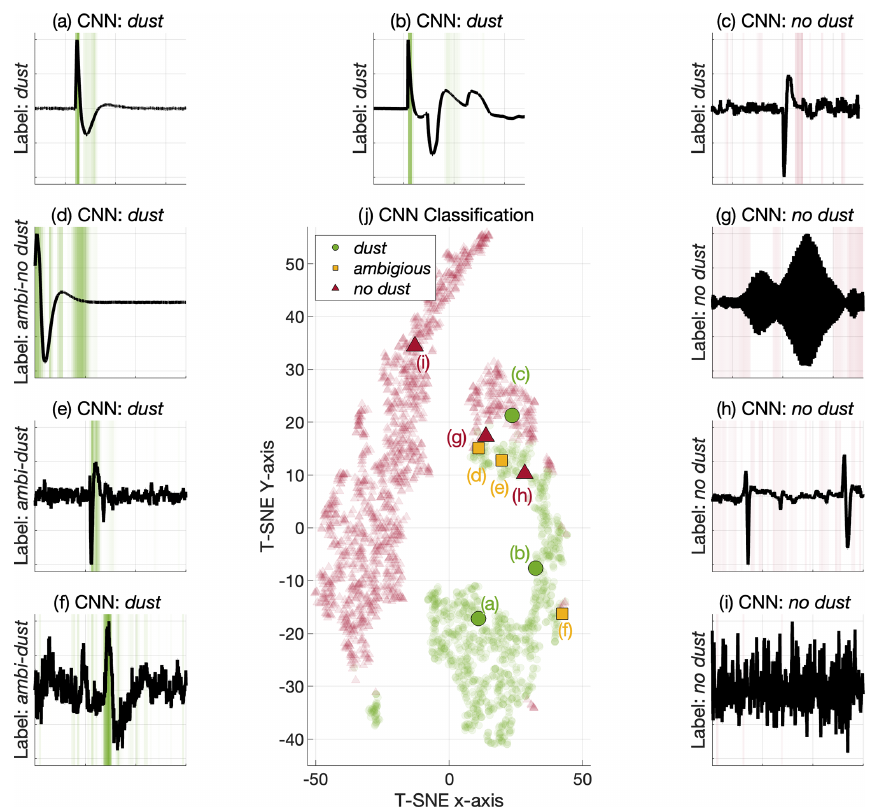
Figure 9. The signal examples and the CAM analysis are presented in (a) – (i) , the manual labels are indicated along the y axis and the predicted label, classified by the CNN, is presented in the subplot titles. The highlighted green color indicates the CAM values associated with the dust class, the green regions therefore emphasize the regions that are considered important by the CNN for detecting dust impact signatures. Similarly, the red color indicates the regions that are influential for the no dust class. Note that the signals are zoomed to 15ms intervals around the interesting features, similar to Figs. 1 and 6. Panel (j) presents the associated signal examples in the t -SNE space along with the training data signals as transparent points. The dust signals are illustrated by the green dots, the ambiguous signal examples are marked in yellow and the no dust signals are indicated in red. The t -SNE map shows that the clear dust signals (a–b) are distinctly located in a green ( dust ) region, whereas the clear no dust signal (i) is distinctly located in a red ( no dust ) region. The remaining signals are located in more mixed regions. It should however be noted that the observations are represented by a 128-dimensional feature vector in the CNN and that the (2-D) t -SNE representation presented in (j) diminishes a lot of information, meaning that even the signals located in a mixed region of the t -SNE plot might be separable in the 128-dimensional feature vector